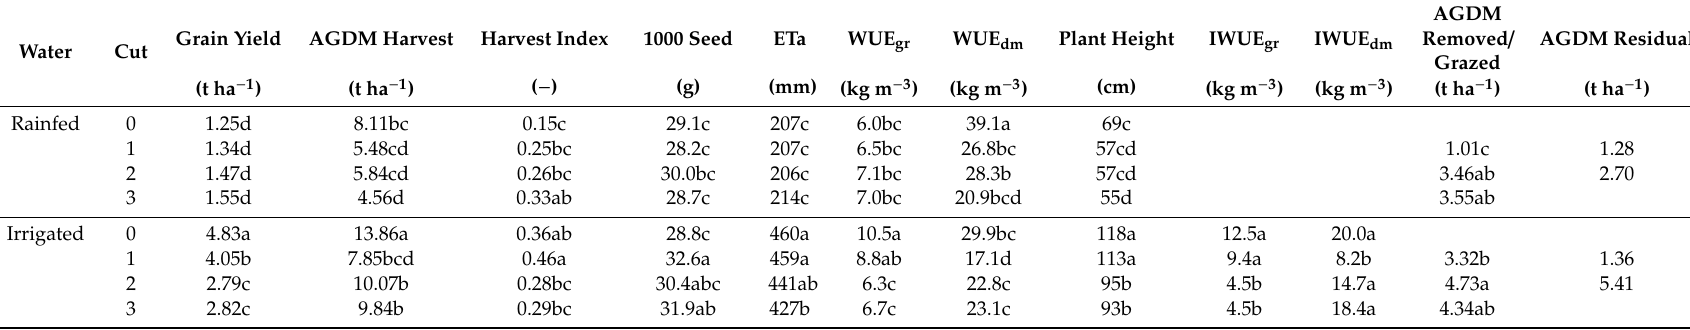
Table 3. Analysis of variance of the crop growth, dry matter, harvest parameters, and water productivity for unirrigated and irrigated dual-purpose wheat.